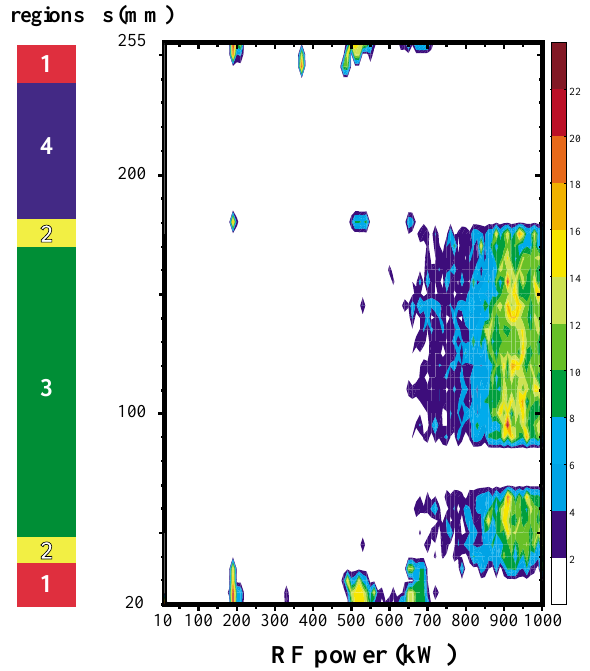
FIG. 4. (Color) Simulated log (cid:1) N e (cid:2) as a function of rf input power and electron starting position s for the cavity-type TW